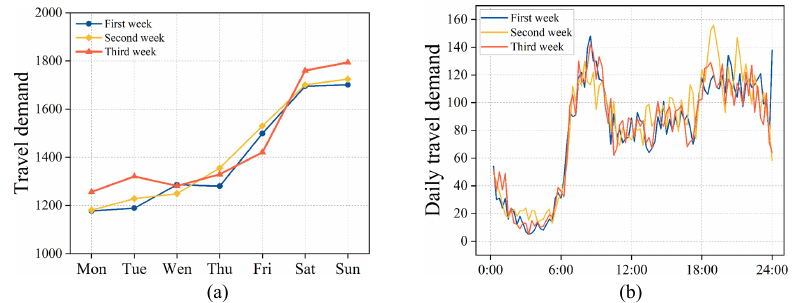
Figure 5. ( a ) Total daily travel demand for a region for three consecutive weeks; ( b ) daily travel demand on Monday of each week for three consecutive